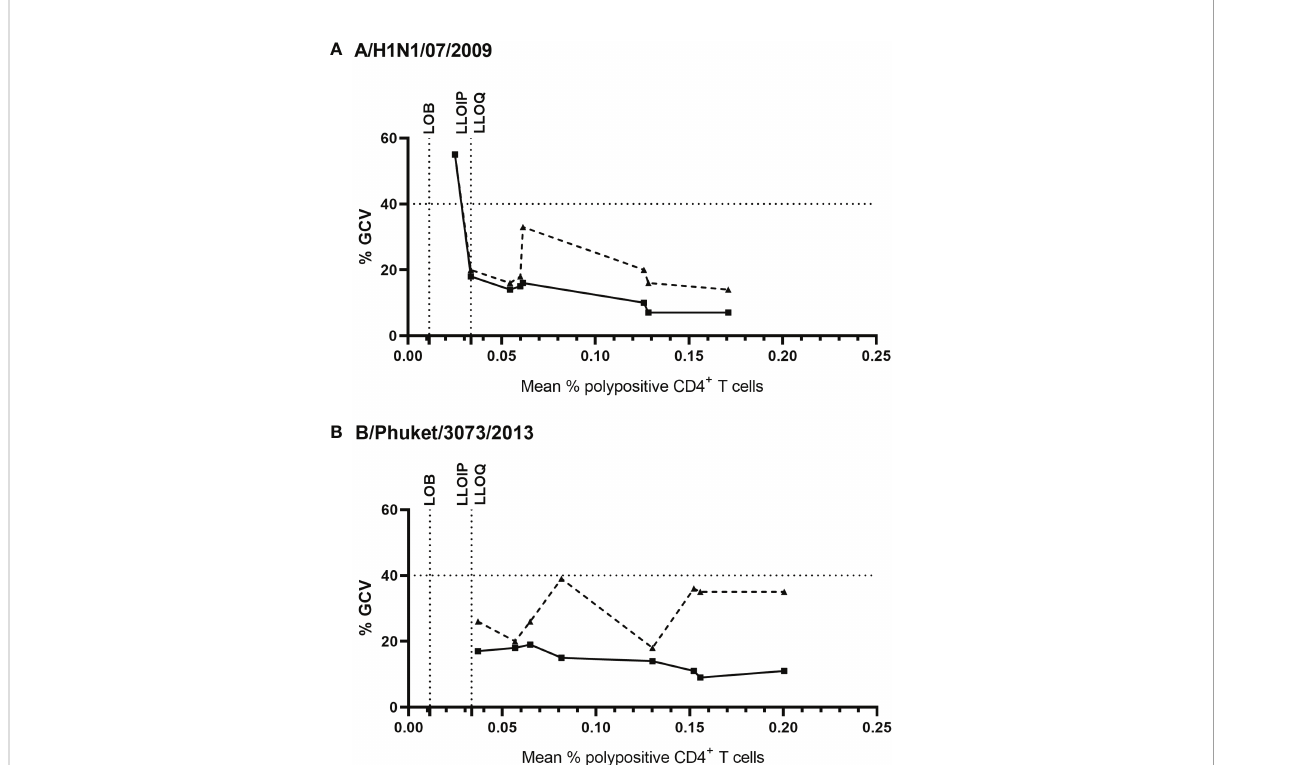
FIGURE 5 Intra- and inter-assay %GCV for A/California/07/2009 (A) and B/Phuket/3073/2013 (B) . The solid black line indicates the intra-assay %GCV, the dashed line indicates the inter-assay %GCV. For each of the 8 samples tested for precision, the %GCV was calculated (y-axis) and is plotted against the mean response (x-axis). The horizontal dotted line represents a GCV of 40%, the vertical dotted lines indicate the LOB, and LLOIP/ LLOQ. %GCV, percentage of geometric coef fi cient of variation; LLOIP, lower limit of intermediate precision; LLOQ, lower limit of quanti fi cation; LOB, limit of